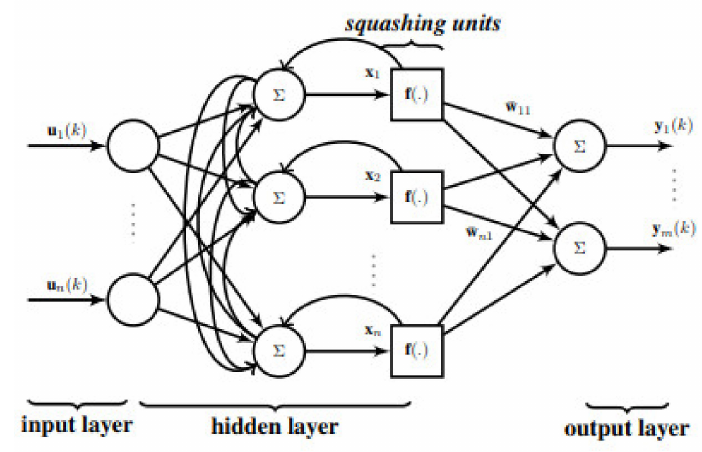
Figure 1. A simple recurrent neural network.